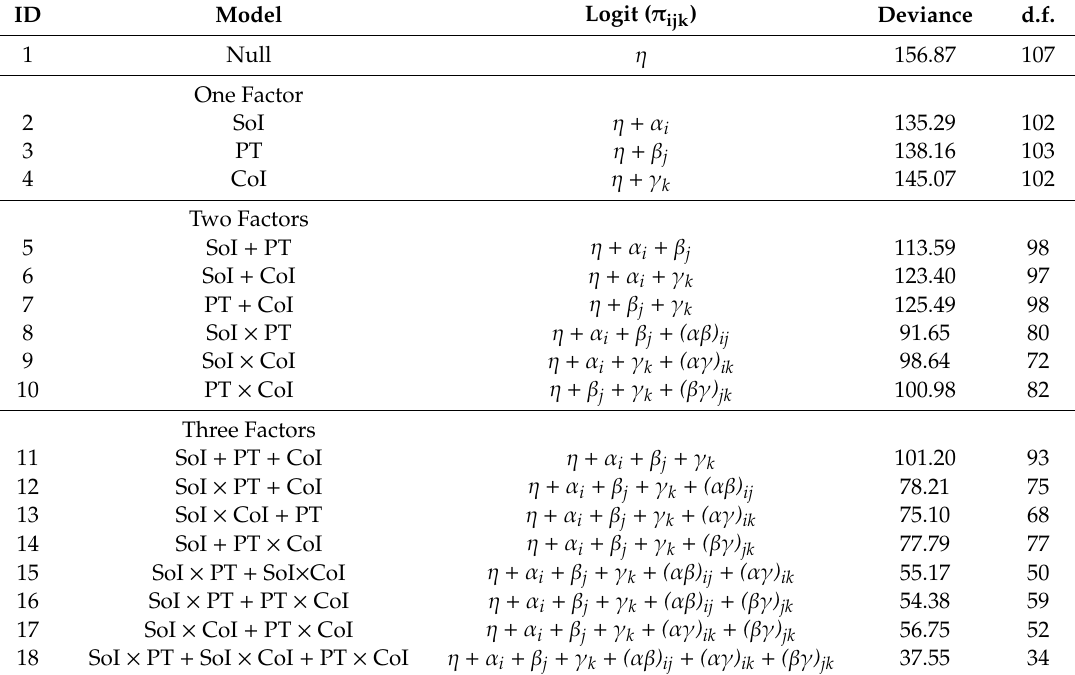
Table 2. Deviance for logit models of fatality by “source of injury,” “project group,” and “project cost”. ID Model Logit ( π ijk ) Deviance